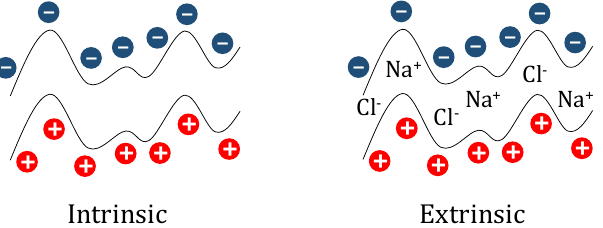
Figure 3. Scheme of the expected configuration of polyelectrolyte layers and counterions in intrinsi- cally and extrinsically compensated polyelectrolyte